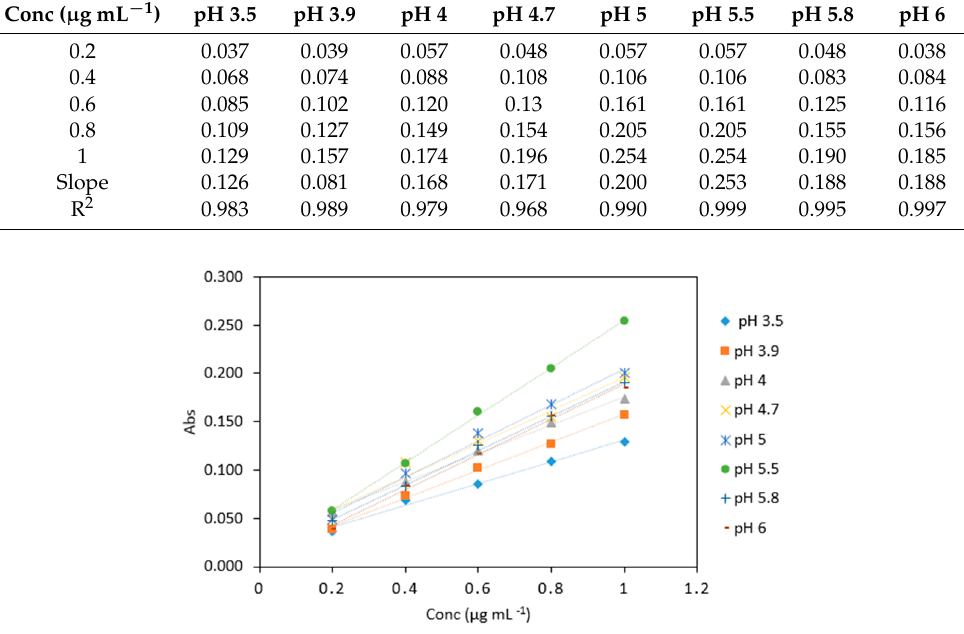
Figure 6. Comparison of arsenic samples (0.2–1 μ g mL − 1 ) analyzed using various sodium triacetate buffers (pH 3.5, 3.9, 4, 4.7, 5, 5.5, 5.8, 6). All measurements were carried out in triplicate ( n = 120).